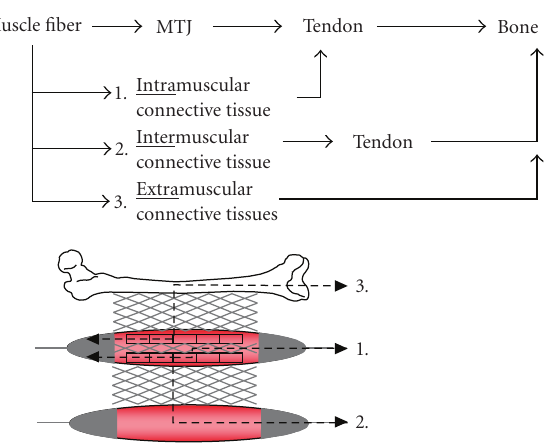
Figure 1: The di ff erent pathways via which force generated within muscle fibers can leave the muscle to be transmitted to the